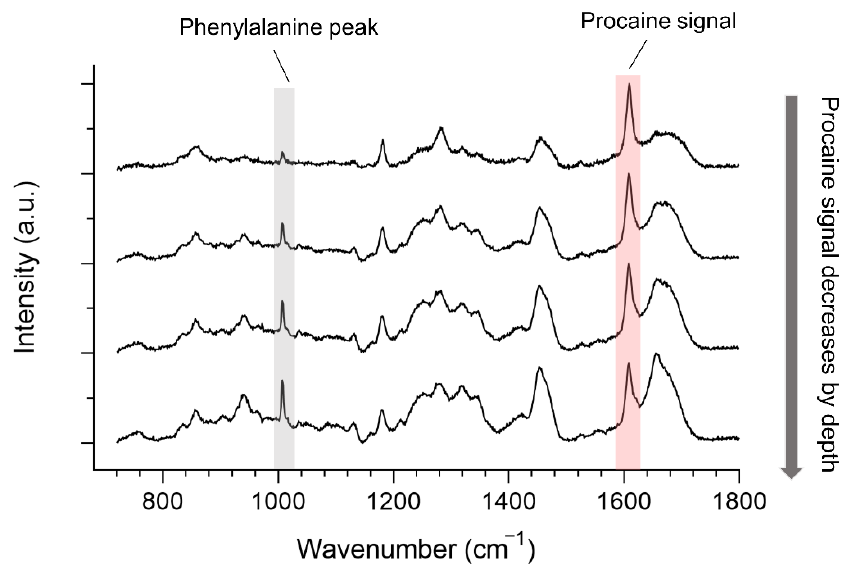
Figure 3. Typical spectra in in-line skin analysis of procaine signal decreasing by depth with crucial spectral features, which are highlighted in color.